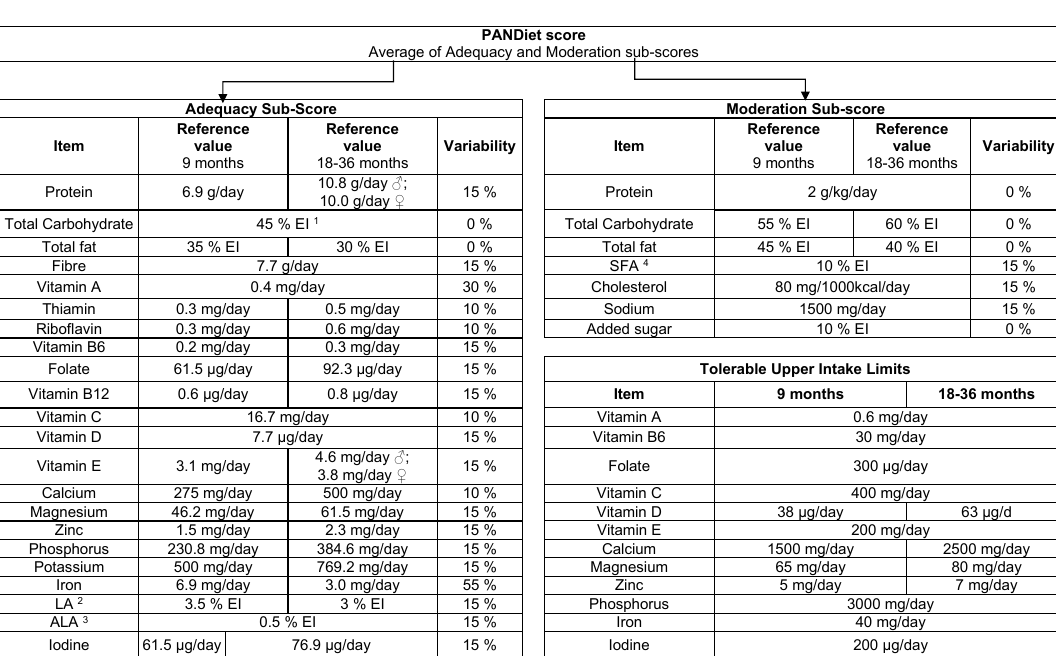
Figure A1. Flow ‐ diagram of study cohort. Figure A1. Flow-diagram of study cohort.